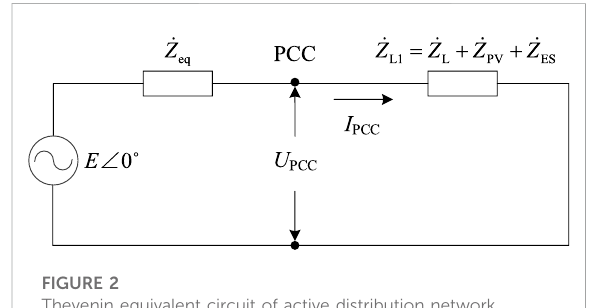
FIGURE 2 Thevenin equivalent circuit of active distribution network.